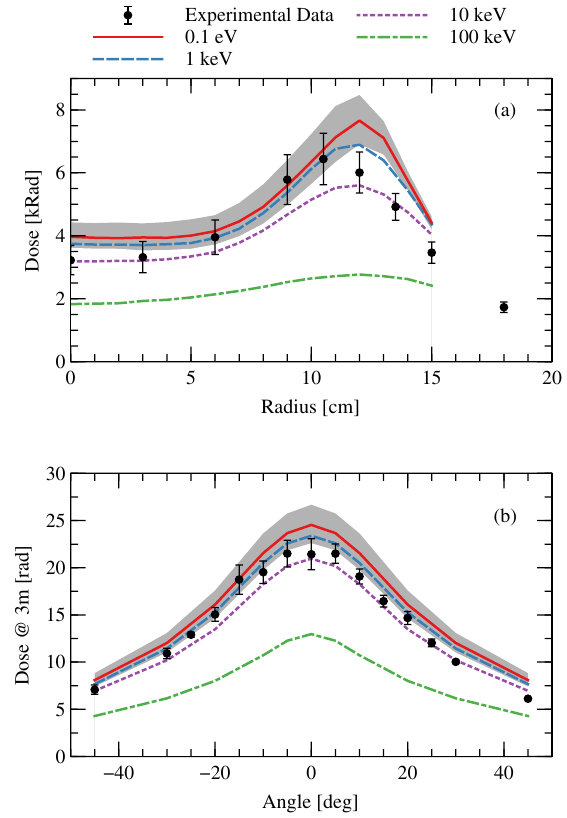
FIG. 7. Comparison of measured (points) and simulated (curves) doses from simulation Case 0 and Cases M1 – M3, in (a) the near field and (b) the far field. The main effect of increasing electron emission temperature on the computed dose distributions is a reduction in total dose produced, due to its effect on the MITL operating